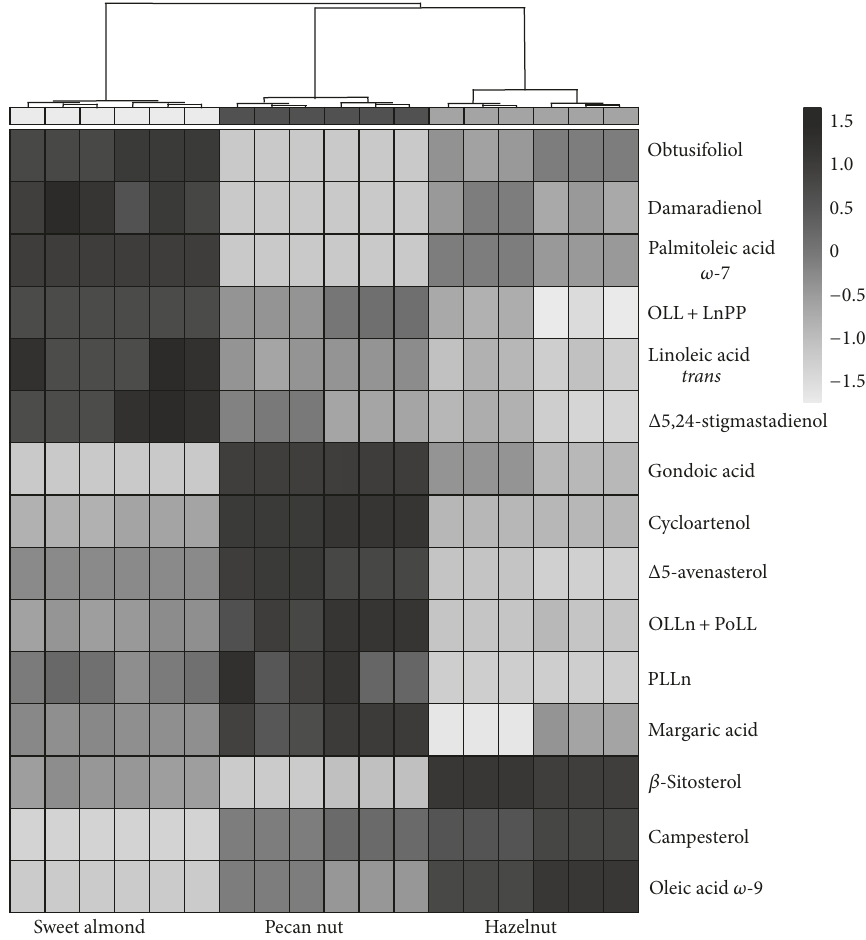
Figure 2: Cluster hierarchical analysis and heatmap of the fifteen more important features for sample grouping, selected by random forest statistical